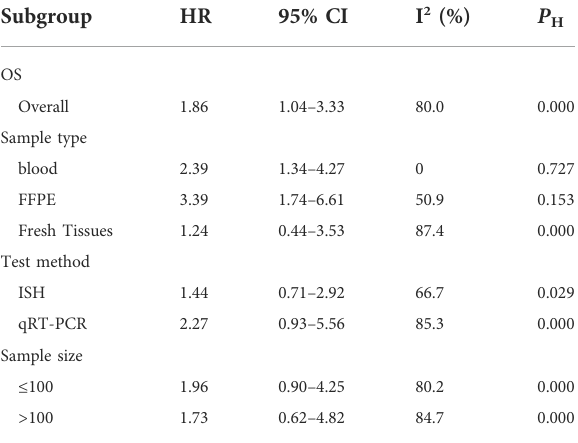
TABLE 4 Results of quantitative analysis.